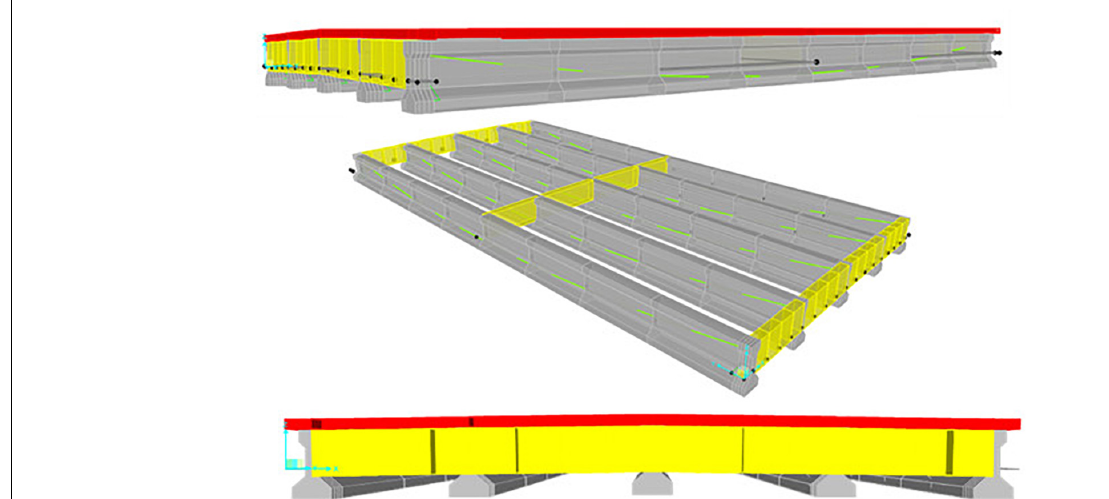
FIGURE 5 | FE Model of the bridge.